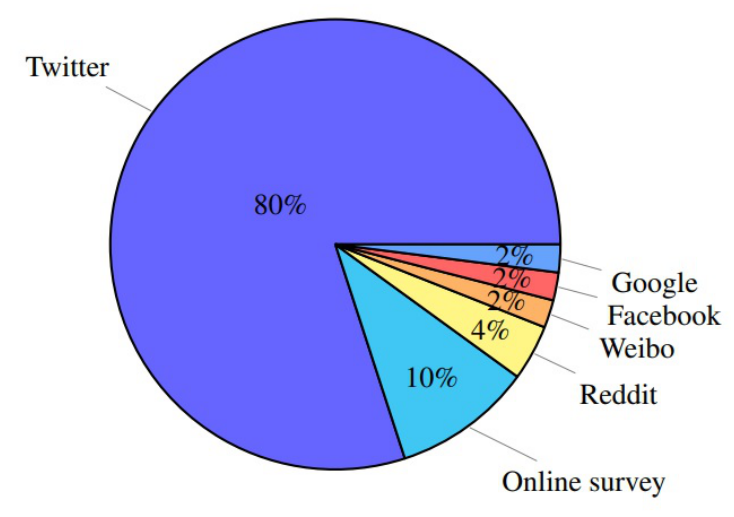
Figure 4. Frequency of data sources used in the publications for sentiment analysis in the context of COVID-19